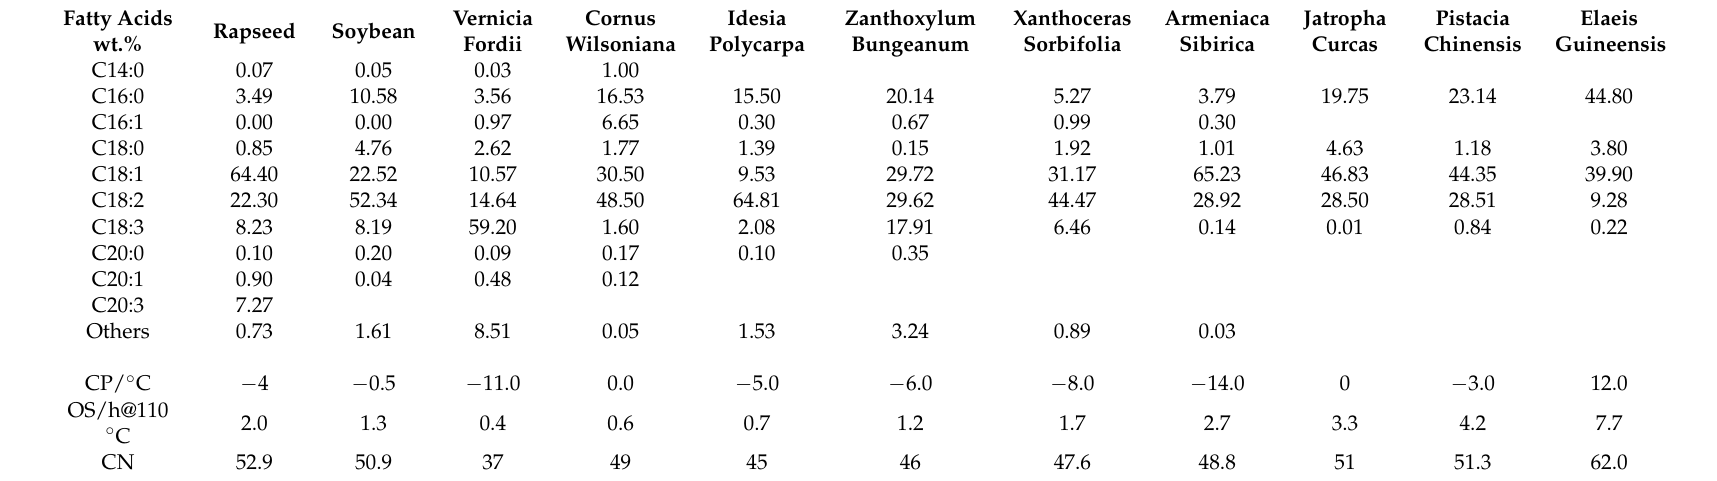
Table A1. FAME compositions and fuel properties